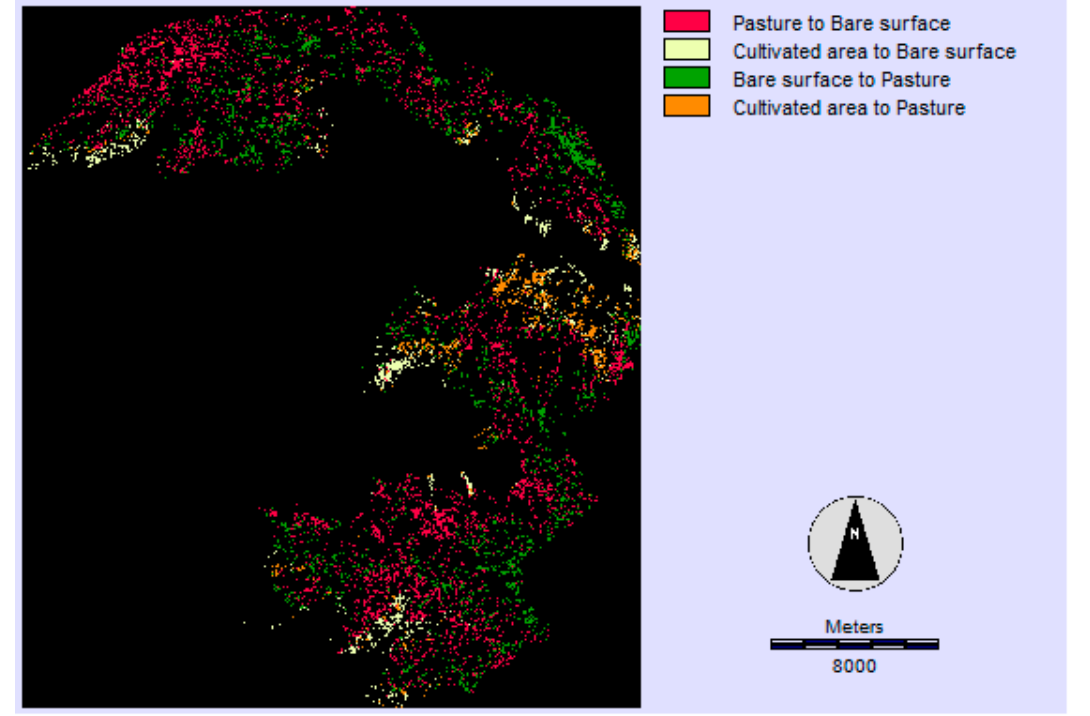
Figure 3. LULC change by category in two time spans (1998–2015) in the upper and lower parts of HSCZ.